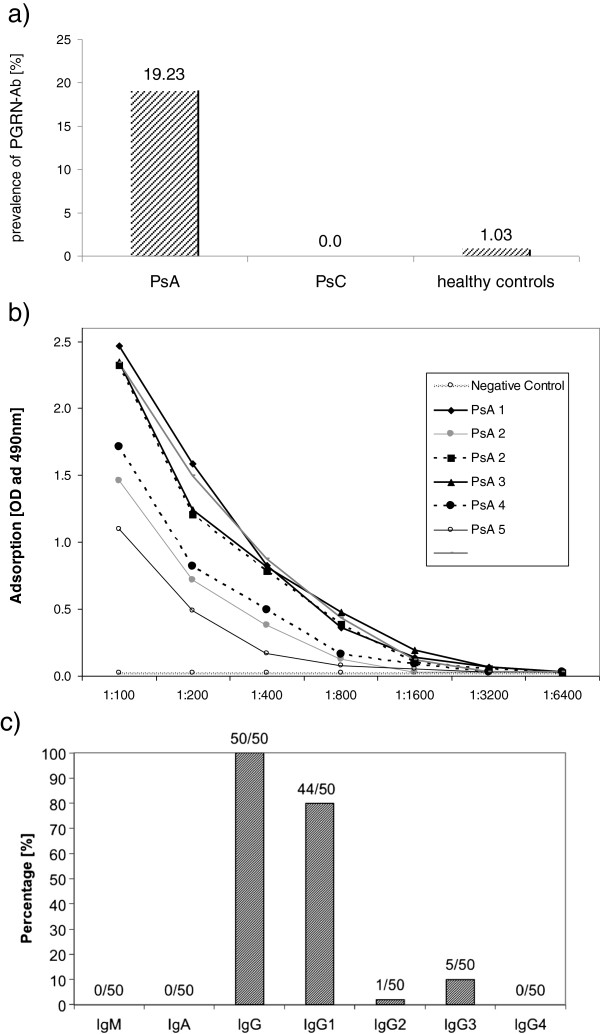
Occurrence of progranulin antibodies in psoriatic arthritis patients. (a) Prevalence of progranulin antibodies (PGRN Abs) in psoriatic arthritis (PsA) patients. (b) Titres of PGRN Abs in PsA patients. (c) Frequency of different immunoglobulin classes of PGRN Abs in PsA patients. Ig: immunoglobulin; OD, optical density; PsC: psoriasis without arthritic manifestations.